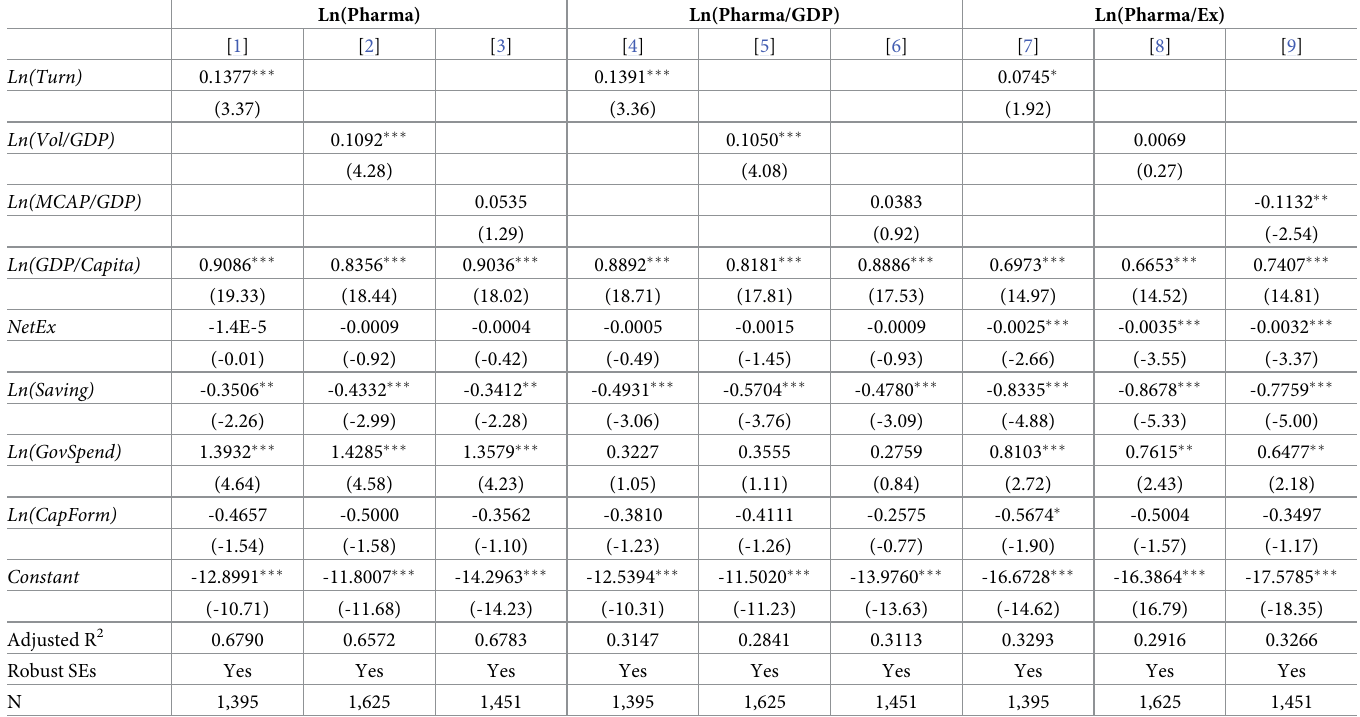
Table 4. Pharmaceutical innovation and equity market